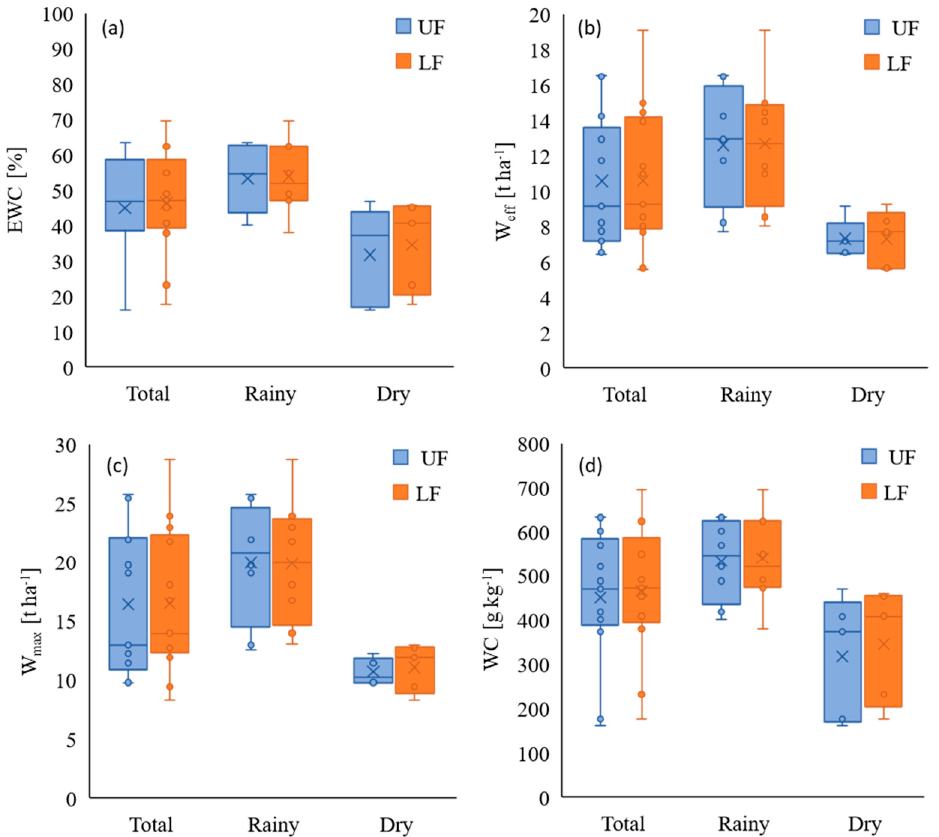
Figure 4. Monthly ( a ) e ff ective water-holding capacity (EWC, %), ( b ) e ff ective water-retention ca- pacity (W e ff , t ha − 1 ), ( c ) maximum water-retention capacity (W max , t ha − 1 ), ( d ) and li tt er water content (WC, g water kg li tt er − 1 ) in unlogged and logged forest. Jamari National Forest, Rondônia, Brazil.